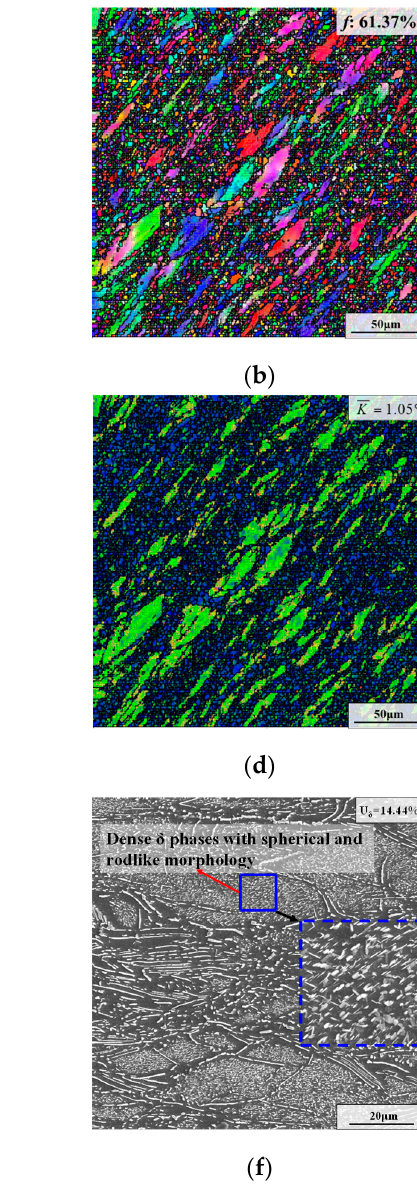
11 of 20 Figure 8. Microstructures after the first annealing stage with varying strain rates of: ( a , c , e ) 0.001 s − 1 ; ( b , d , f ) 0.01 s − 1 . (The deformation temperature is 950 °C, and the true strain is 0.69). As presented in Figures 7a and 8a,b, the recrystallization fraction after AT first in ‐ creased from 35.54% to 39.05% and then decreased to 23.52% as the strain rate declined from 0.1 s − 1 to 0.01 s − 1 and 0.001 s − 1 . At the same time, the average KAM value was 1.49°, 1.26° and 1.37°, respectively (Figures 7d and 8c,d). 3.2.3. Effect of True Strain Figure 9 illustrates microstructures after AT with different true strains. As demon ‐ strated in Figures 7g and 9e,f, the weight fraction of the δ phase descended from 31.72% to 25.41% and 14.44% when the true strain was elevated from 0.36 to 0.69 and 1.20. When the true strain was 0.36, the δ phases formed during AT precipitated in the form of clusters with spherical morphology within the deformed grains, which is similar to the precipita ‐ tion characteristics of the specimen with a true strain of 0.69 (Figures 7g and 9e). The reason for this is that the content of the δ phase after deformation was extremely high (Figure 6e), which means that the content of Nb atoms in the matrix was extremely small. At the same time, there were many intragranular δ phase nuclei after deformation, and the low Nb atom content preferentially promotes the growth of these phase nuclei, resulting in the appear ‐ ance of δ phase clusters with spherical morphology. However, the morphology and distri ‐ bution of the δ phases varied obviously when the true strain increased to 1.20. There were large numbers of spherical and rodlike δ phases in deformed grains. This is because of the